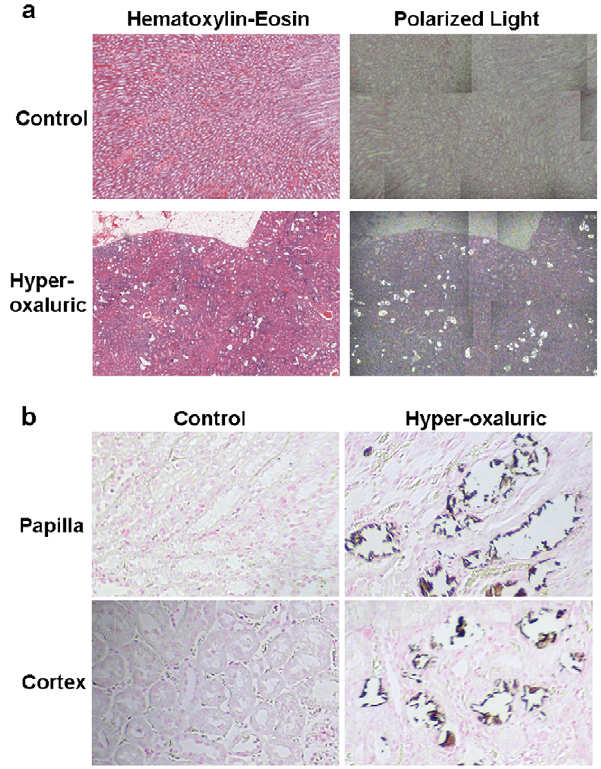
Figure 4. Hyper-oxaluric rats showed crystal deposits of Calcium Oxalate in renal tubules after 3 weeks. ( a ) Hematoxylin and Eosin stained paraffin embedded 5 um sections were photo- graphed under polarized light to detect crystal deposits in the tubules. Representative Images captured using a 10 6 objective magnification are shown. ( b ) Von Kossa’s staining method was used to identify Calcium deposition in tubules of hyper-oxaluric rat kidneys. Digital photo-micrographs were taken with a 10 6 magnification. Representa- tive images are shown.